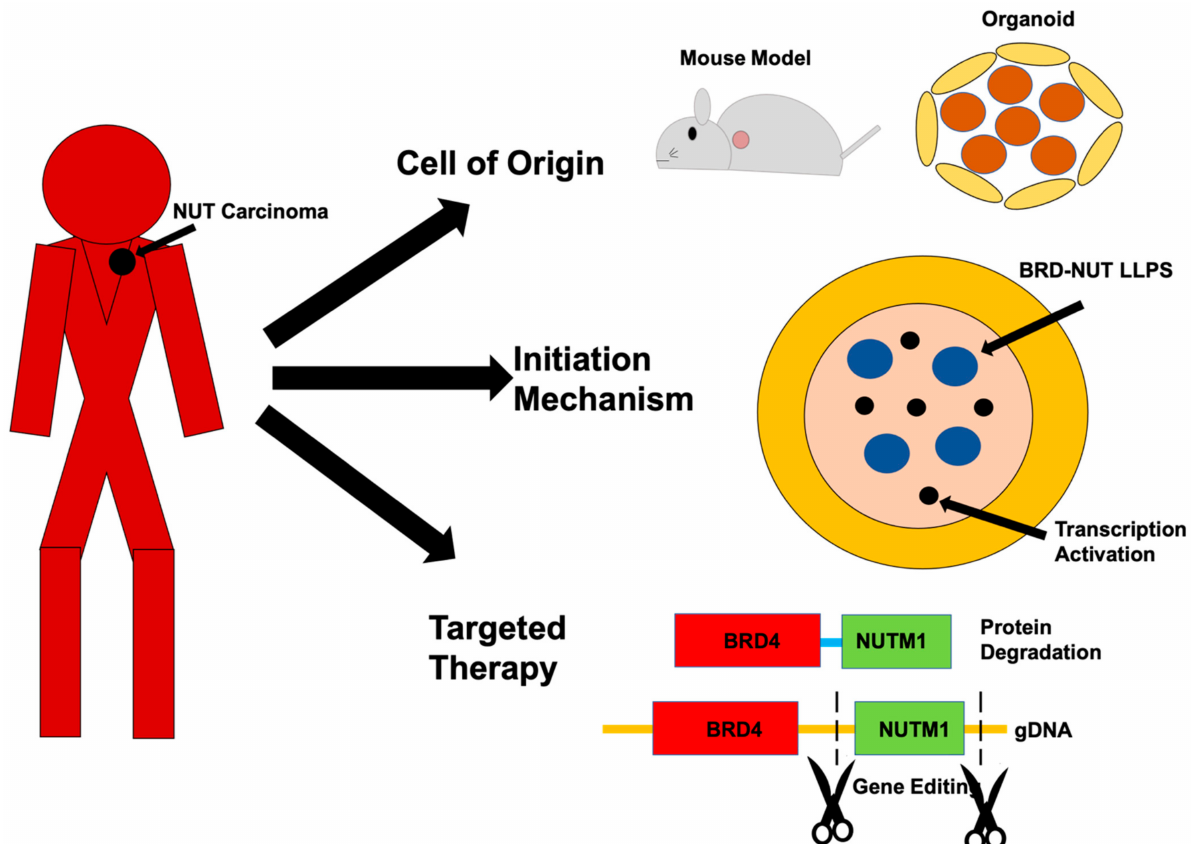
Figure 1. Challenges and opportunities in NUT carcinoma (NC) research. This review article raises three challenges in NC research: (1) What is the cell of origin of NC? (2) How do NUTM1 fusion genes cause NC? (3) How can we develop targeted therapies for NC? We propose these challenges can be effectively addressed now using new technological advancements in biomedical research, including genetically modified mouse models, organoids, imaging analysis of liquid–liquid phase separation (LLPS) and transcription, and targeted protein degradation and CRISPR-cas9 based gene